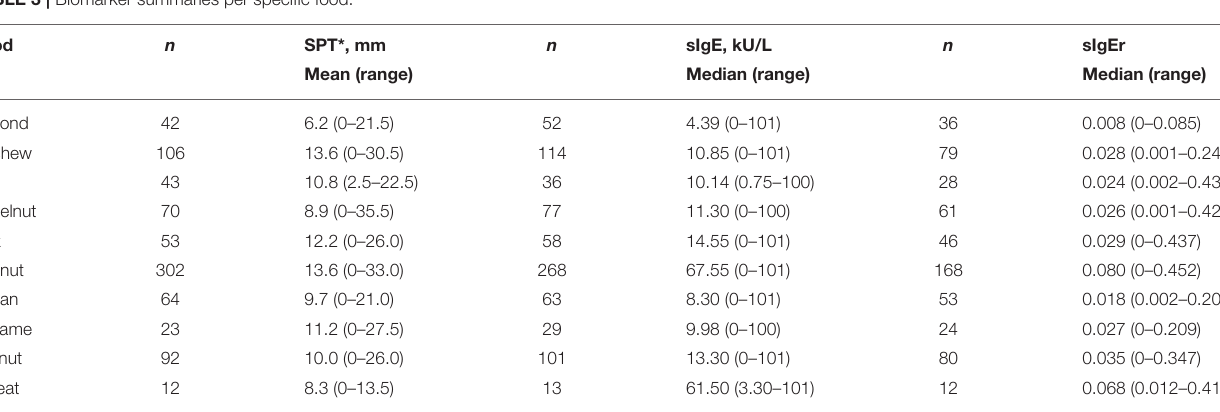
TABLE 3 | Biomarker summaries per specific